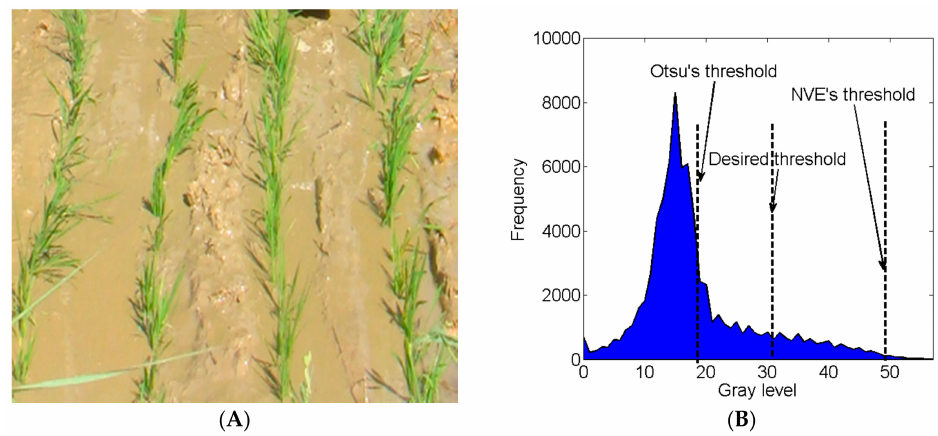
Figure 8. ( A ) original image; ( B ) histogram and threshold values of ( A